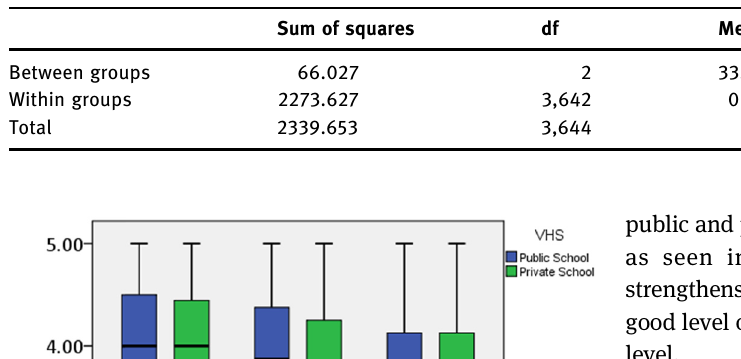
Table 21: Descriptive of awareness level by public school and private school N Mean Std. deviation Std. error 95% con fi dence interval for mean Minimum